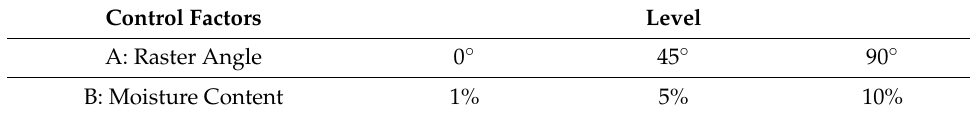
Table 2. Process factors and levels.